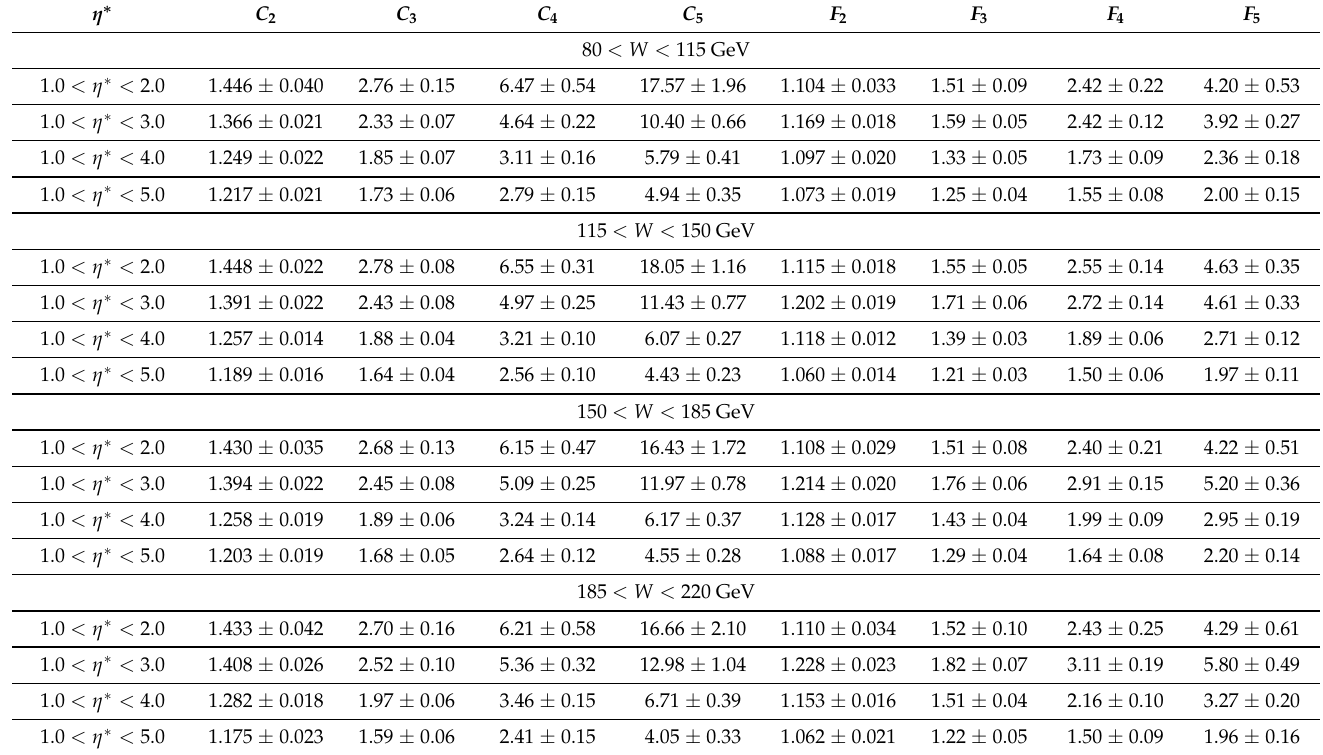
Table 3. Normalised moments and normalised factorial moments calculated from the SGD fits to the data [33] for different W ranges.